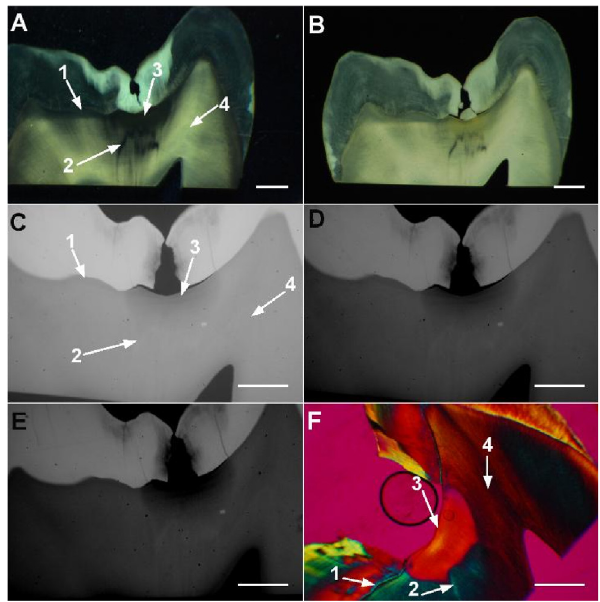
Figure 1. Typical aspects of dentin reactions in selected histological sites (labeled 1–4 with arrows) of natural occlusal caries (ICDAS II score 2). Translucent dentin is shown in sites 1–3 from the SW image ( A ) and in sites 1 and 2 from the SD image ( B ). Site 1 appears as demineralized dentin in all types of MR images and as negatively birefringent (“carious dentin”) in PLMQ ( F ). Site 2 appears as normal dentin in the NFNBC image ( C ), as hypermineralized (sclerotic) in both NFBC ( D ) and FBC ( E ) images, and as negatively birefringent in PLMQ. Site 3 appears as carious (yellowish) dentin in the SD image ( B ), as demineralized dentin in all types of MR images, and as positively birefringent (“normal”) in PLMQ. The appearance of site 4 is of normal dentin in all images. Bars = 1 mm.